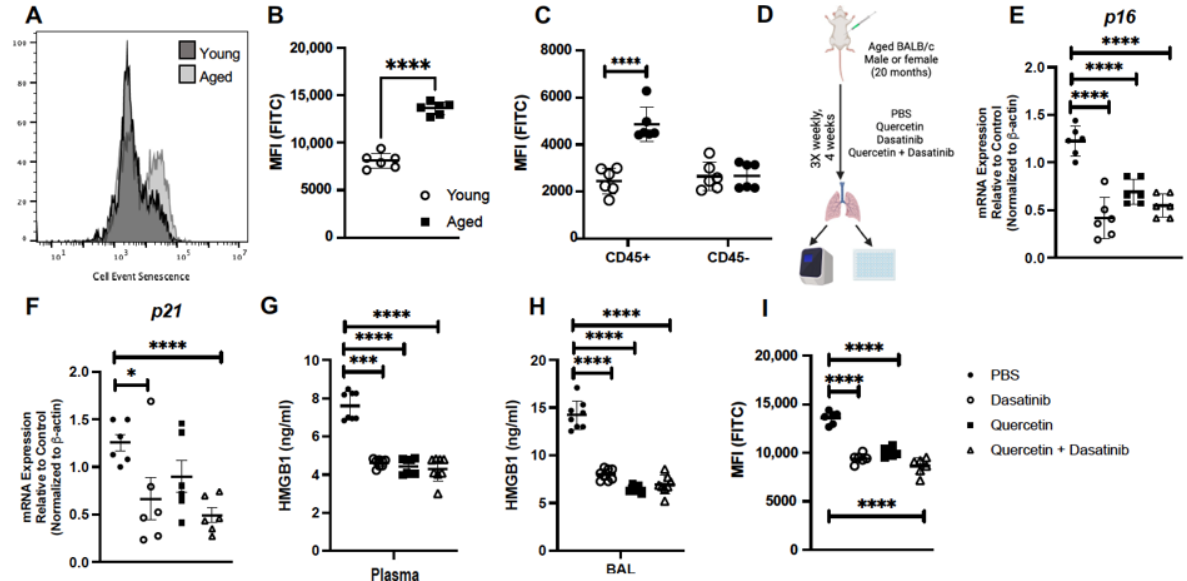
Figure 1. Treatment of Aged Mice with Senolytics Reduced p16 and p21 Gene Expression in Lung. ( A – C ) Baseline β -galactosidase hydryolysis in lung cells isolated from young (3 months) and aged (20 months) lung cells. ( C ) Lung cells were enriched for CD45, and β -galactosidase hydryolysis was assessed in CD45 + and CD45 − populations. ( D ) Experimental layout for senolytic treatment regimen in aged adult BALB/c mice (20 months). Lung tissue was collected from control and treated mice and expression of ( E ) p16 and ( F ) p21 was assessed by real-time PCR. ( G ) Plasma and ( H ) BAL was isolated and HMGB1 was assessed. ( I ) β -galactosidase hydryolysis in aged lung in response to senolytic treatment was assessed by flow cytometry. N = 6 mice per group, and the experiment was repeated 3 times. * p < 0.05, *** p < 0.001, **** p < 0.0001. Figure 1D was prepared using BioRender.